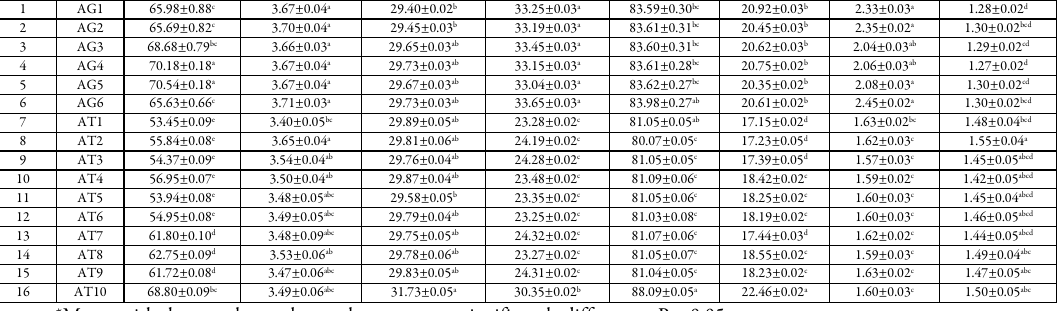
*Means with the same letter along columns are not significantly different at P ≤